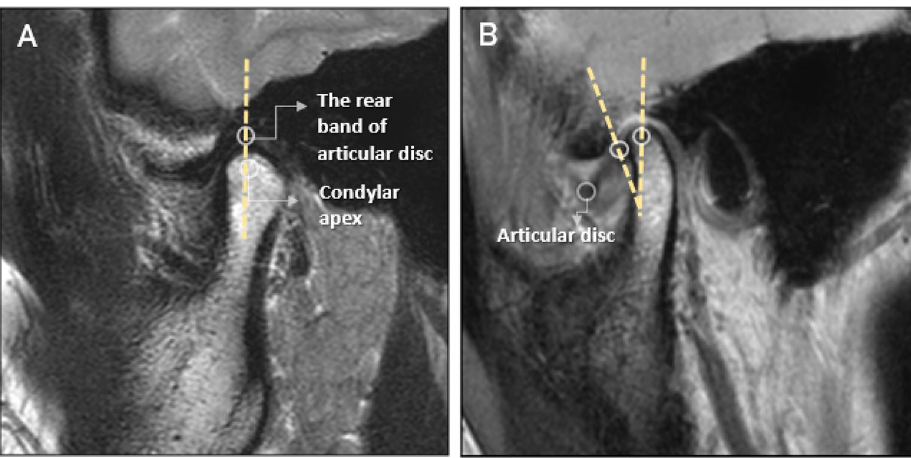
Figure 2. Magnetic resonance imaging (MRI) features of non-anterior disc displacement (non-ADD) ( A ) and ADD ( B ). Non-ADD: the rear band of the articular disc is located at 12 o’clock relative to the condylar apex at the closed position. ADD: the rear band of the articular disc moves forward beyond the normal range in the closed-mouth